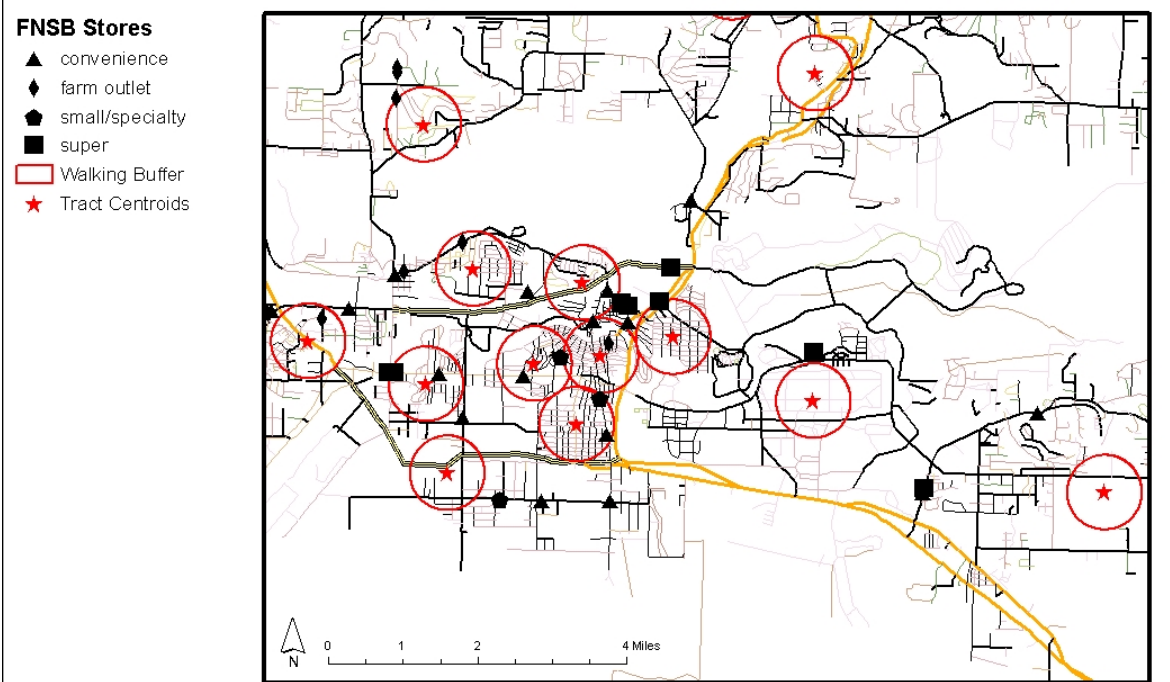
Figure 4. Half-mile Walking Distance Buffers Around Census Tract Population